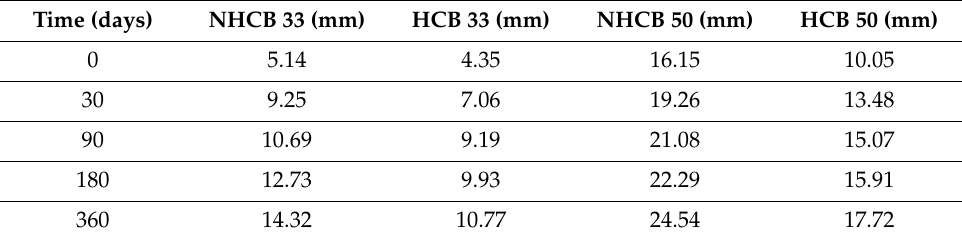
Table 2. Long-term deflections of RC beams strengthened with